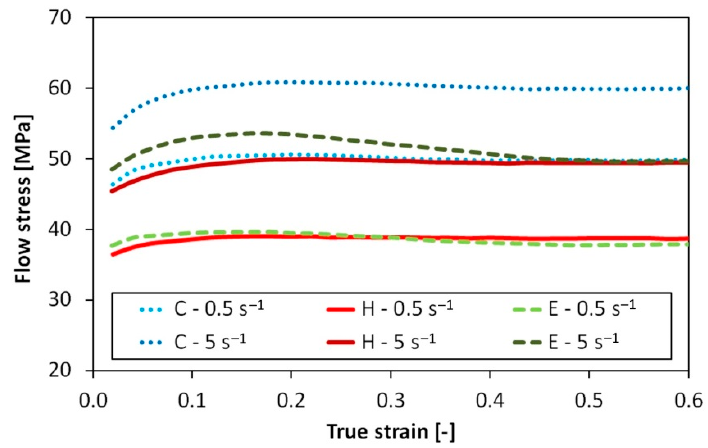
Figure 7. Stress-strain curves for a temperature of 450 °C.